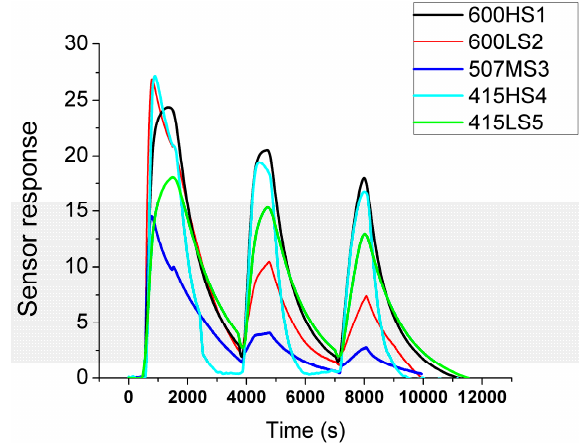
Figure 5. Successive response and recovery of the ZnO thin films to decreasing concentrations (20, 10 and 5 ppm) of ethanol diluted in dry air. All sensors were operated at 200 °C.